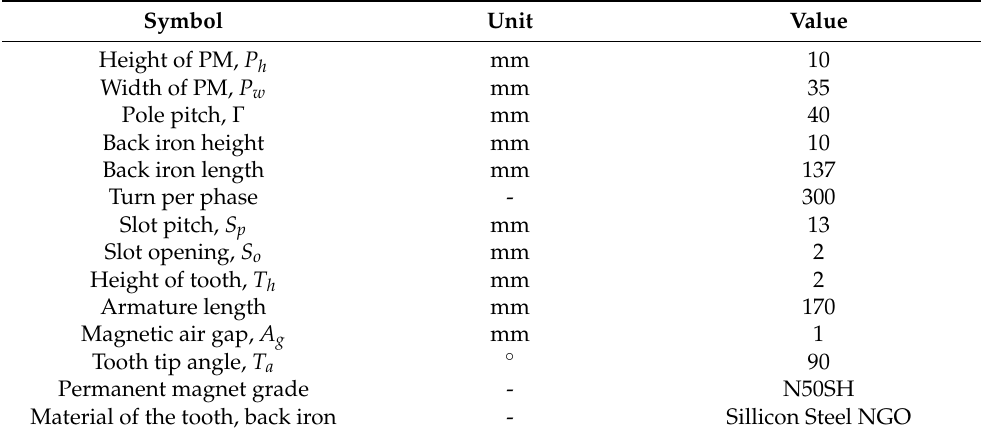
Figure 2. 2D finite elements analysis model. Table 1. Specifications of the discontinuous armature arrangement PMLSM.